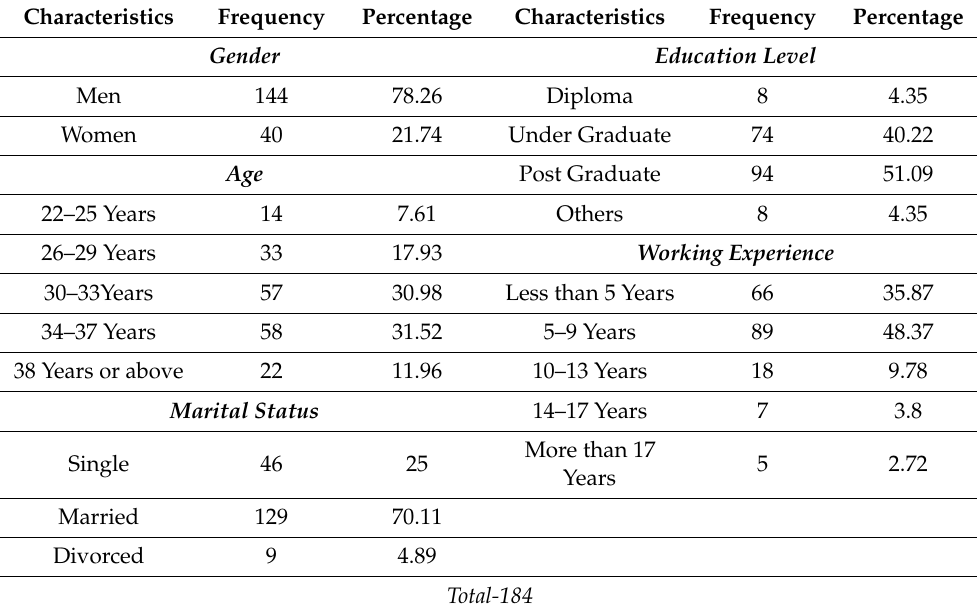
Table 1. Demographic profiles of respondents.